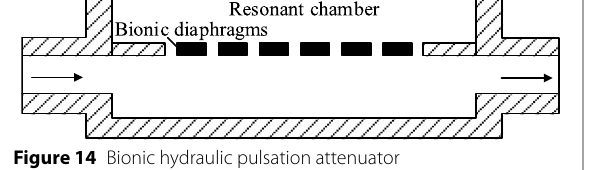
Figure 14 Bionic hydraulic pulsation attenuator